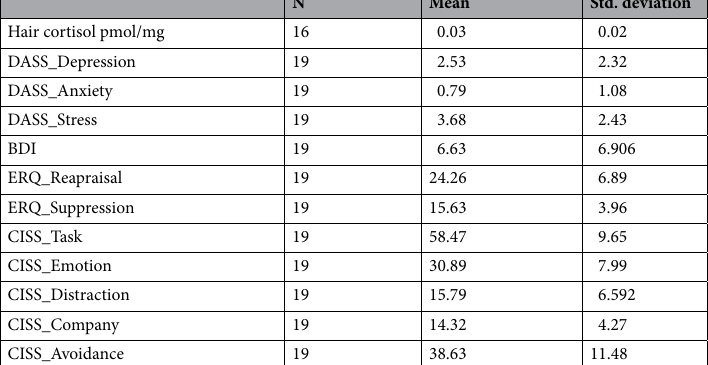
Table 1. Mean values, standard deviations and sample size for sum scores of the questionnaires. DASS21: A-anxiety (norm 1.75[3.13]), D-depression (norm 2.8[4.1]), S-distress (norm 4.7[3.61]) 13 . BDI: cut-off 13 for mild depression. CISS-21: T—task oriented coping, E—emotion oriented coping, A—avoidance oriented coping. ERQ: Cognitive reappraisal (norm 29[6.68]), Expressive suppression facet (norm 15.97[5.16]) 14 . The normative value is given in mean and SD in